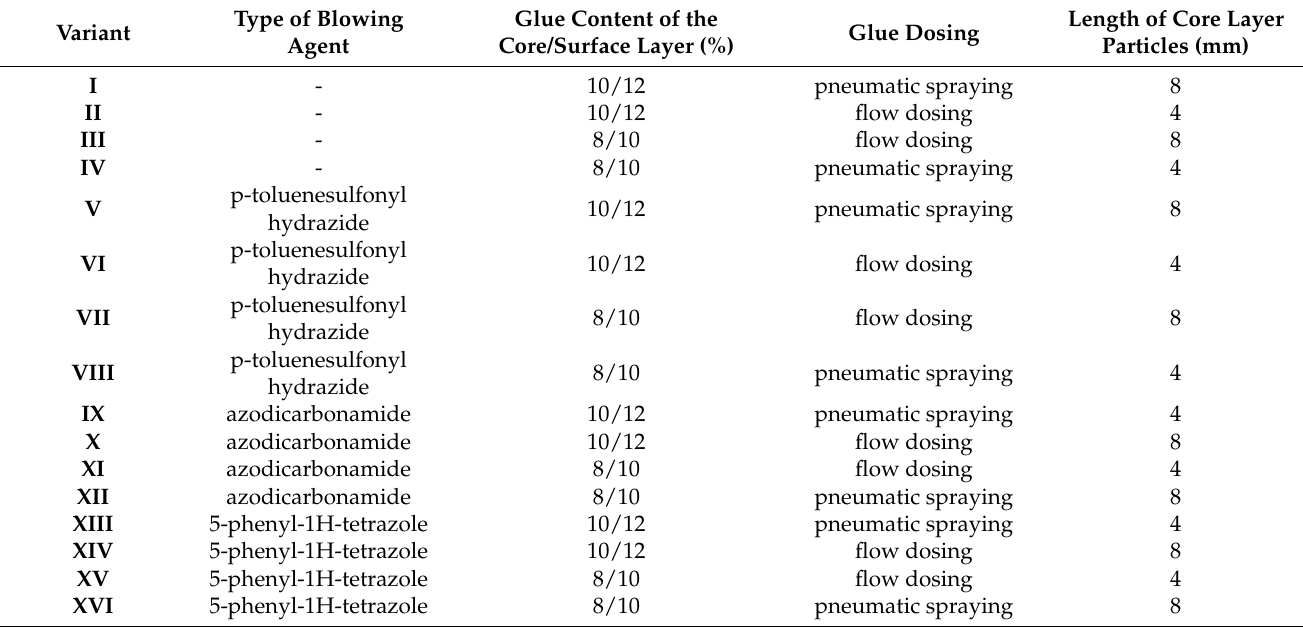
Table 1. Characteristics of the assumptions of individual variants within which three-layer particle- boards were